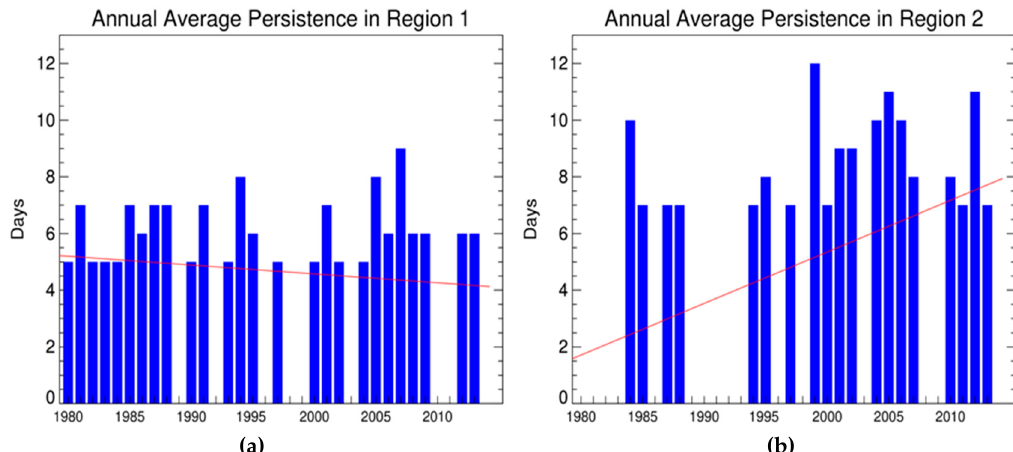
Figure 8. Annual average of the persistence (days) of the heat wave events in regions ( a ) 1 and ( b ) 2. The red line represents the trend of heat wave persistence.